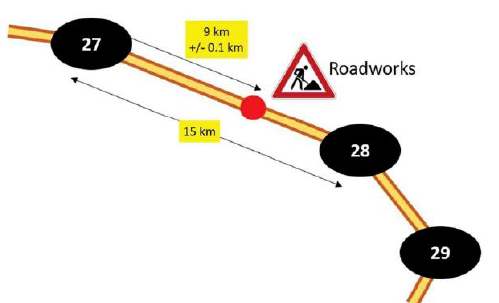
Figure 1: Georeferencing in TMC, readapted from Kamalski,